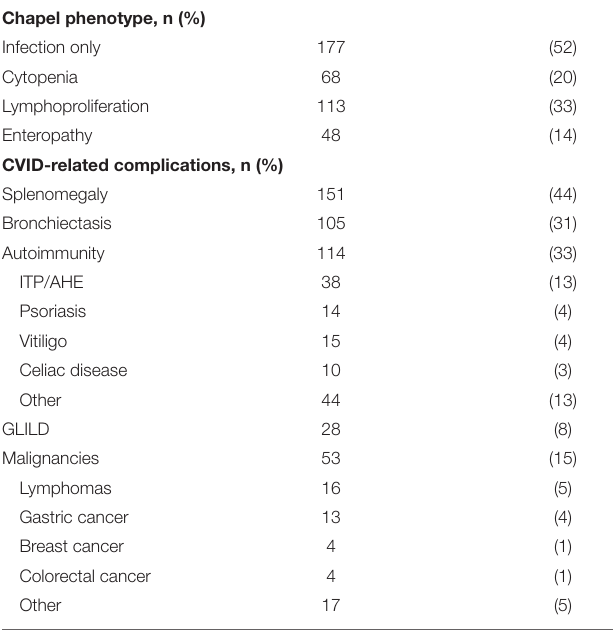
TABLE 2 | Clinical characteristics of 345 CVID patients